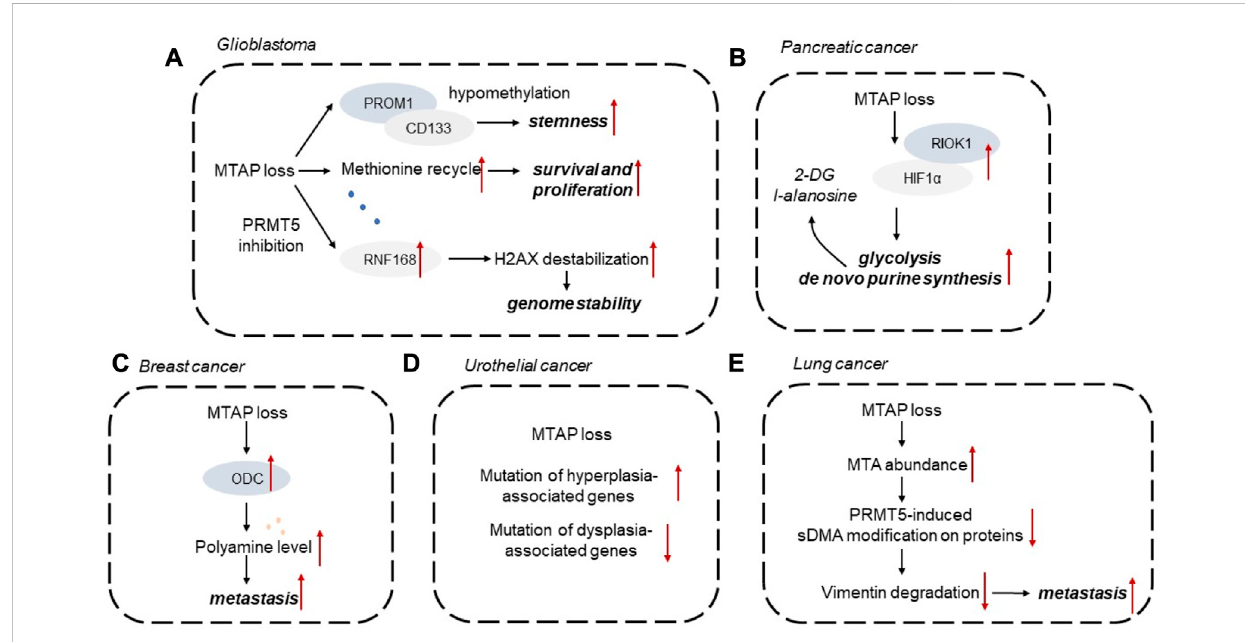
FIGURE 3 Diagrammatic representations of MTAP loss implicated in different types of cancer. (A) Glioblastoma, (B) Pancreatic cancer, (C) Breast cancer, (D) Urothelial cancer, (E) Lung cancer. 2-DG, 2-deoxy-d-glucose; HIF1 α , hypoxia-inducible factor 1 α ; MTA, 5 ′ -methylthioadenosine; ODC, ornithine decarboxylase; sDMA, symmetric